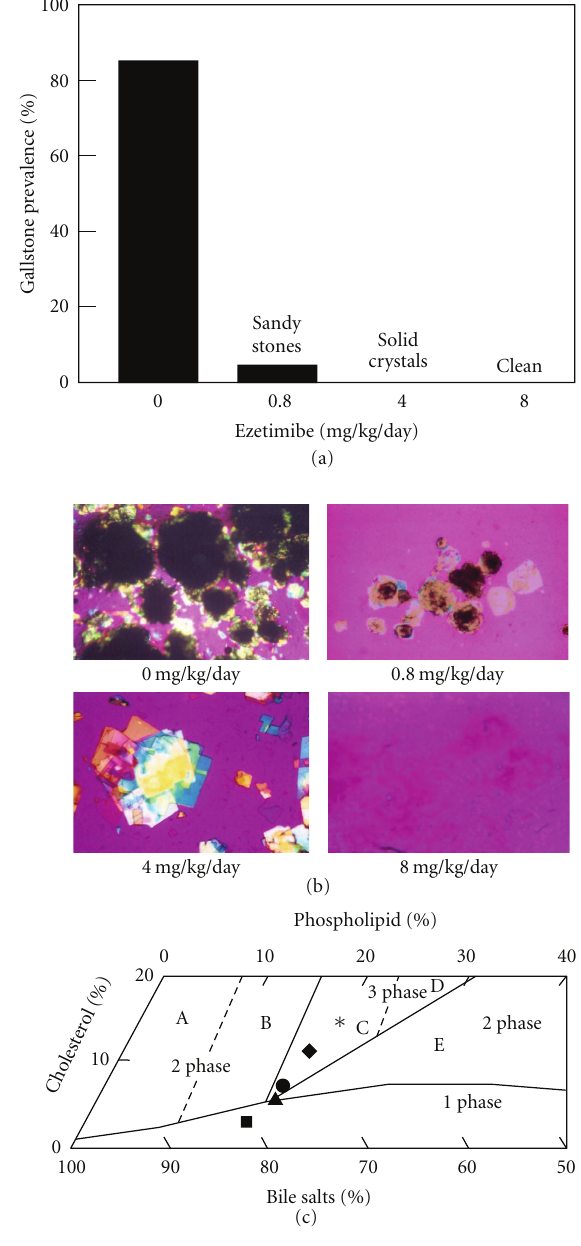
Figure 4: E ff ect of ezetimibe on the dissolution of cholesterol gallstones. (a) For gallstone dissolution experiments, mice with preexisting gallstones were fed a chow diet alone for 8 weeks, which does not result in a spontaneous dissolution of gallstones. In contrast, treatment with ezetimibe at 0.8 to 8mg/kg/day induces rapid dissolution of gallstones. Gallstones were completely dissolved by the highest (8mg/kg/day) dose of ezetimibe. (b) Representative photomicrographs of mucin gel, liquid crystals, cholesterol monohydrate crystals, and gallstones as observed in gallbladder biles at week 8 after ezetimibe treatment. All magnifications are × 800, except for ezetimibe treatment at 0 and 0.8mg/kg/day, which are × 400, by polarizing light microscopy. (c) The relative lipid composition of pooled gallbladder bile from mice fed 8 weeks with the chow diet supplemented with varying doses of ezetimibe is plotted on a condensed phase diagram. Because of a 12- week feeding period of the lithogenic diet, the relative lipid composition of pooled gallbladder bile from mice that have formed cholesterol gallstones is located in the central three-phase zone. Although the lithogenic diet is replaced with the chow diet for 8 weeks, the relative biliary lipid composition of bile is still in region C, where at equilibrium the bile is composed of solid cholesterol crystals, liquid crystals, and saturated micelles. By feeding varying doses of ezetimibe, the relative lipid composition of pooled gallbladder bile gradually shifts down and, finally, enters the one-phase micellar zone. These alterations explain that gallstones are dissolved through an unsaturated micelle mechanism. A symbol ∗ represents relative lipid composition of pooled gallbladder bile from mice that have preexisting gallstones and before ezetimibe treatment; (cid:2) relative lipid composition of pooled gallbladder bile at the end of the gallstone dissolution study at week 8 of feeding the chow diet only (control); • 0.8; (cid:3) 4; (cid:4) 8 mg/kg/day of ezetimibe. Reproduced with modifications and with permission from